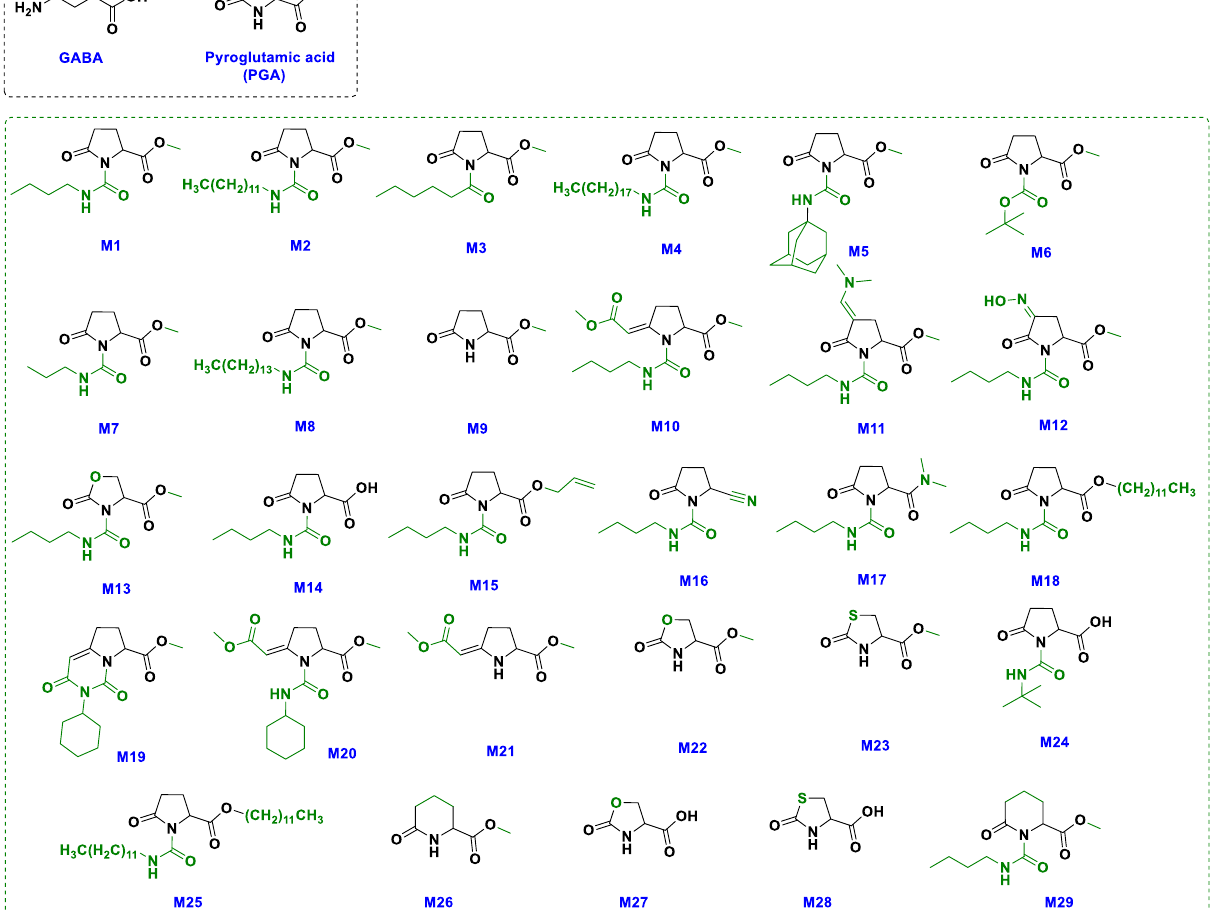
Figure 1. Chemical structure of γ-aminobutyric acid (GABA), pyroglutamic acid (PGA), the molecule M1 derived from PGA, and the 28 molecules (from M2 to M29) derived from